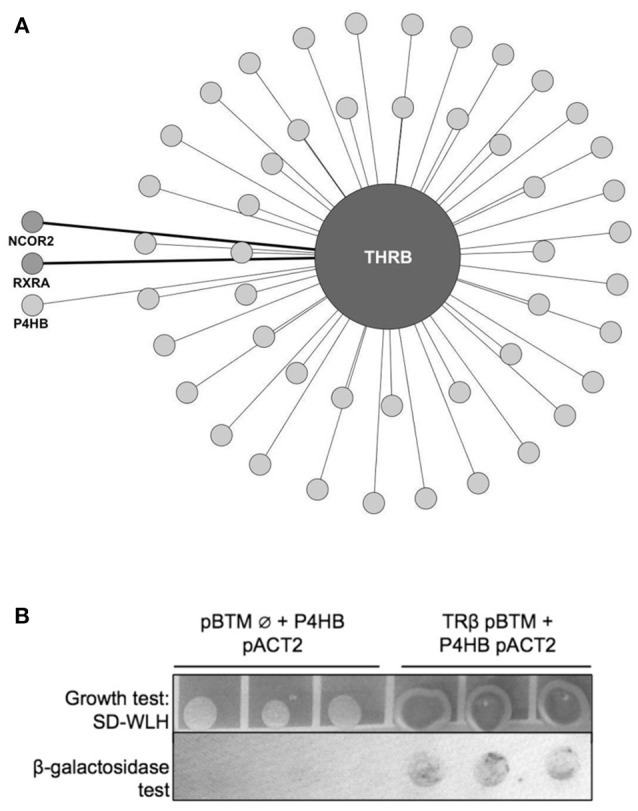
TRβ yeast two-hybrid (y2h) screening. (A) Network created with IIS (Integrated Interactome System) platform and built in Cytoscape 3.3.0 software. Y2H experiments identified 50 preys, among them, light-gray circles represent the new interactors found for TRβ (48 in total), and medium-gray, detached from circle, the already-known TR partners NCOR2 (Nuclear Receptor Corepressor 2) and RXRA (Retinoid X-Receptor α). In light-gray, also detached from circle, we show the new TRβ partner found, Protein Disulfide Isomerase (PDIA1, also known as Prolyl 4-Hydroxylase Subunit Beta—P4HB). (B) Confirmation of PDIA1 and TRβ interaction found in Y2H assay. The TRβ and PDIA1 interaction reconstructed cell transcription factors machinery and transcribed genes that allows colonies to grow, we observe this in dark-grey colonies. Moreover, this interaction produced blue products in the β-galactosidase assay. Negative control with an empty vector (pBTM Ø) had no growth and in β-galactosidase assay, no blue color.